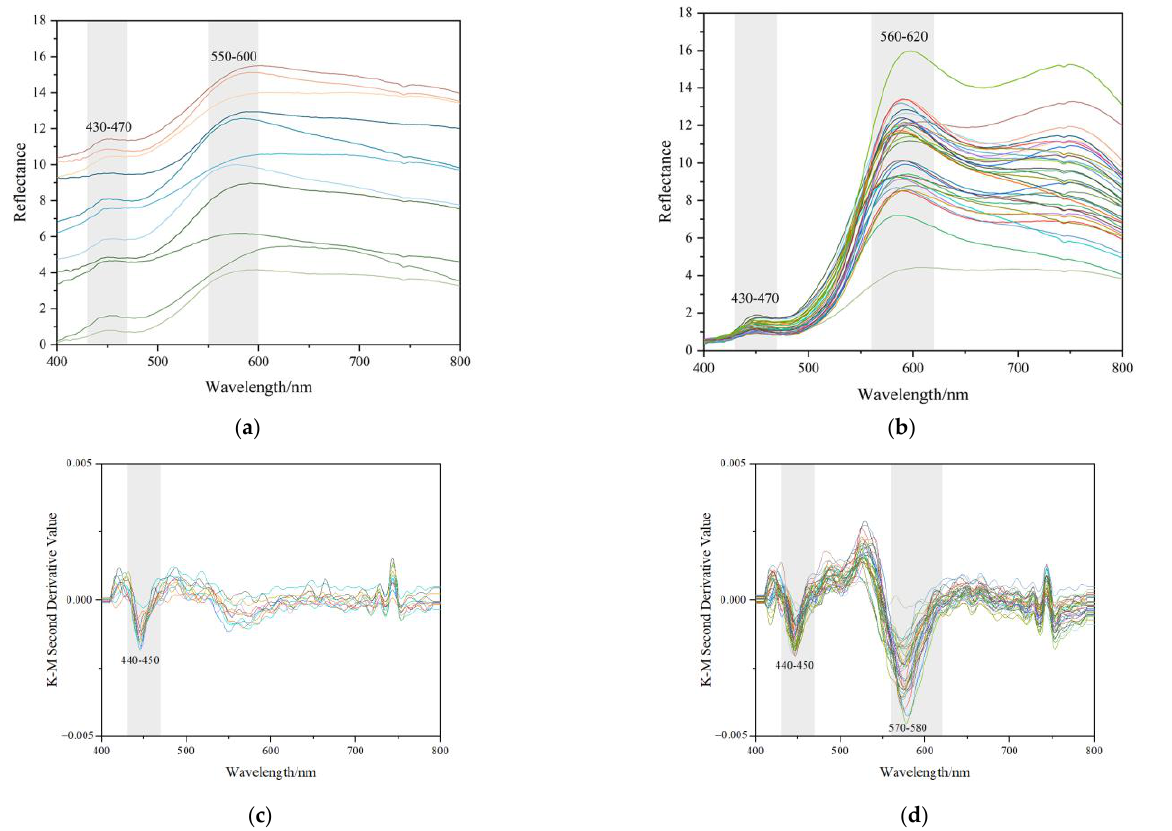
Figure 10. Characteristics of UV-Vis reflectance spectra and K-M 2nd spectra of samples. The intensity of bands at 580~600 nm is stronger than the other band or peaks. ( a ) Reflective UV-Vis spectra collected from lighter colour (mainly yellow) areas; ( b ) Reflective UV-Vis spectra collected from darker colour (mainly orange-yellow) areas; ( c ) K-M 2nd reflective UV-Vis spectra collected from darker colour (mainly yellow) areas; ( d ) K-M 2nd reflective UV-Vis spectra collected from darker colour (mainly orange-yellow) areas.